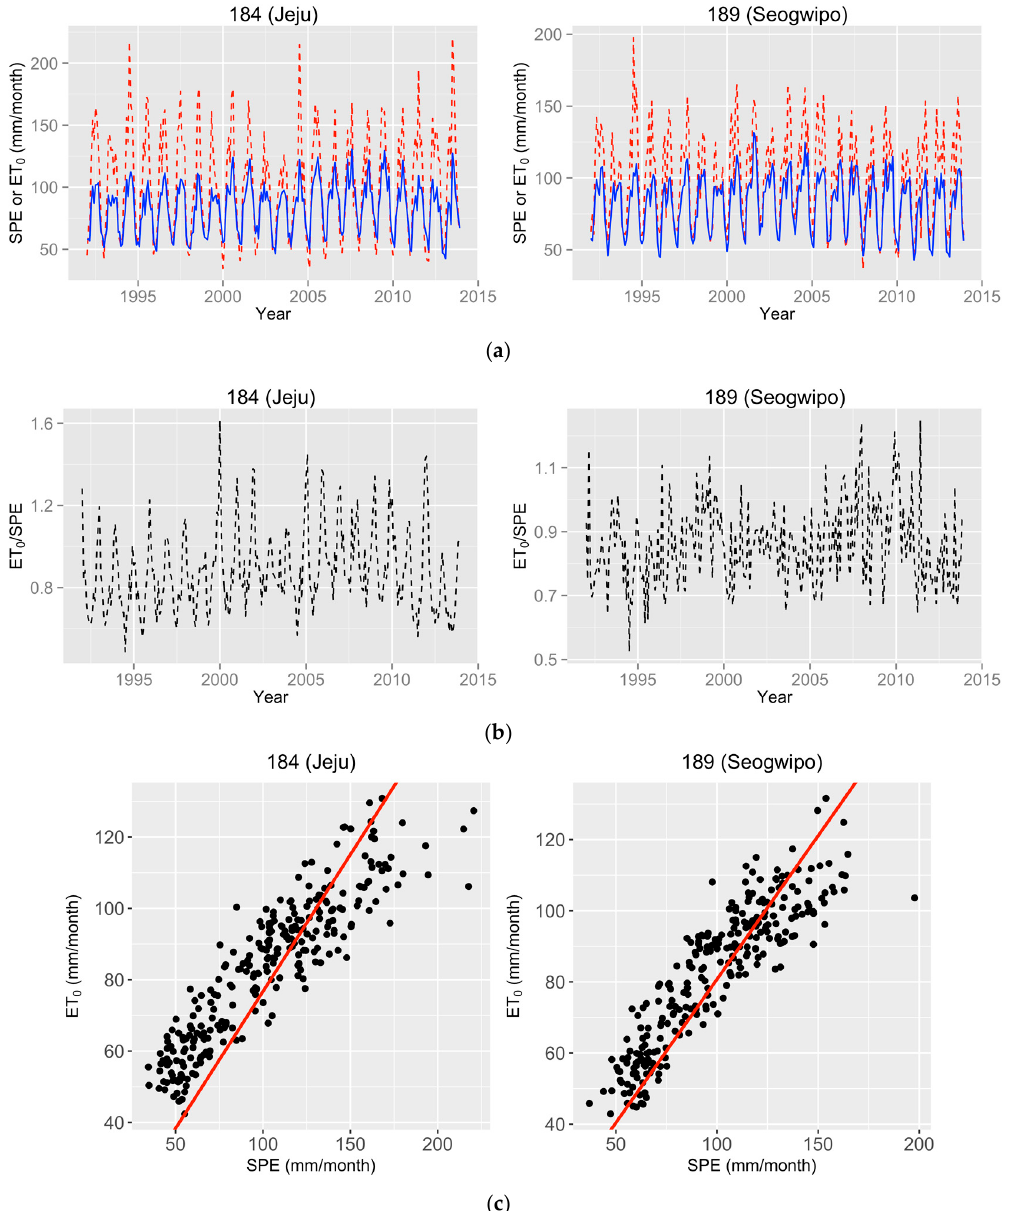
Figure 3. Comparison between the reference crop evapotranspiration (ET) ( ET 0 ) and small pan evaporation (SPE) in mm/month at stations 184 and 189. ( a ) Monthly ET 0 and SPE are indicated using blue and red dashed lines, respectively; ( b ) Monthly pan coefficient; ( c ) Scatter plot between monthly ET 0 ( y -axis) and SPE ( x -axis) showing the linear regression line with an intercept of 0 based on Equation (4) (red line). The slopes of the lines at 184 and 185 are 0.76 and 0.81, respectively.